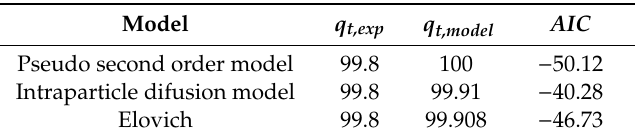
Table 4. Values of Akaike’s information criterion (AIC) for the three kinetic adsorption models used in this